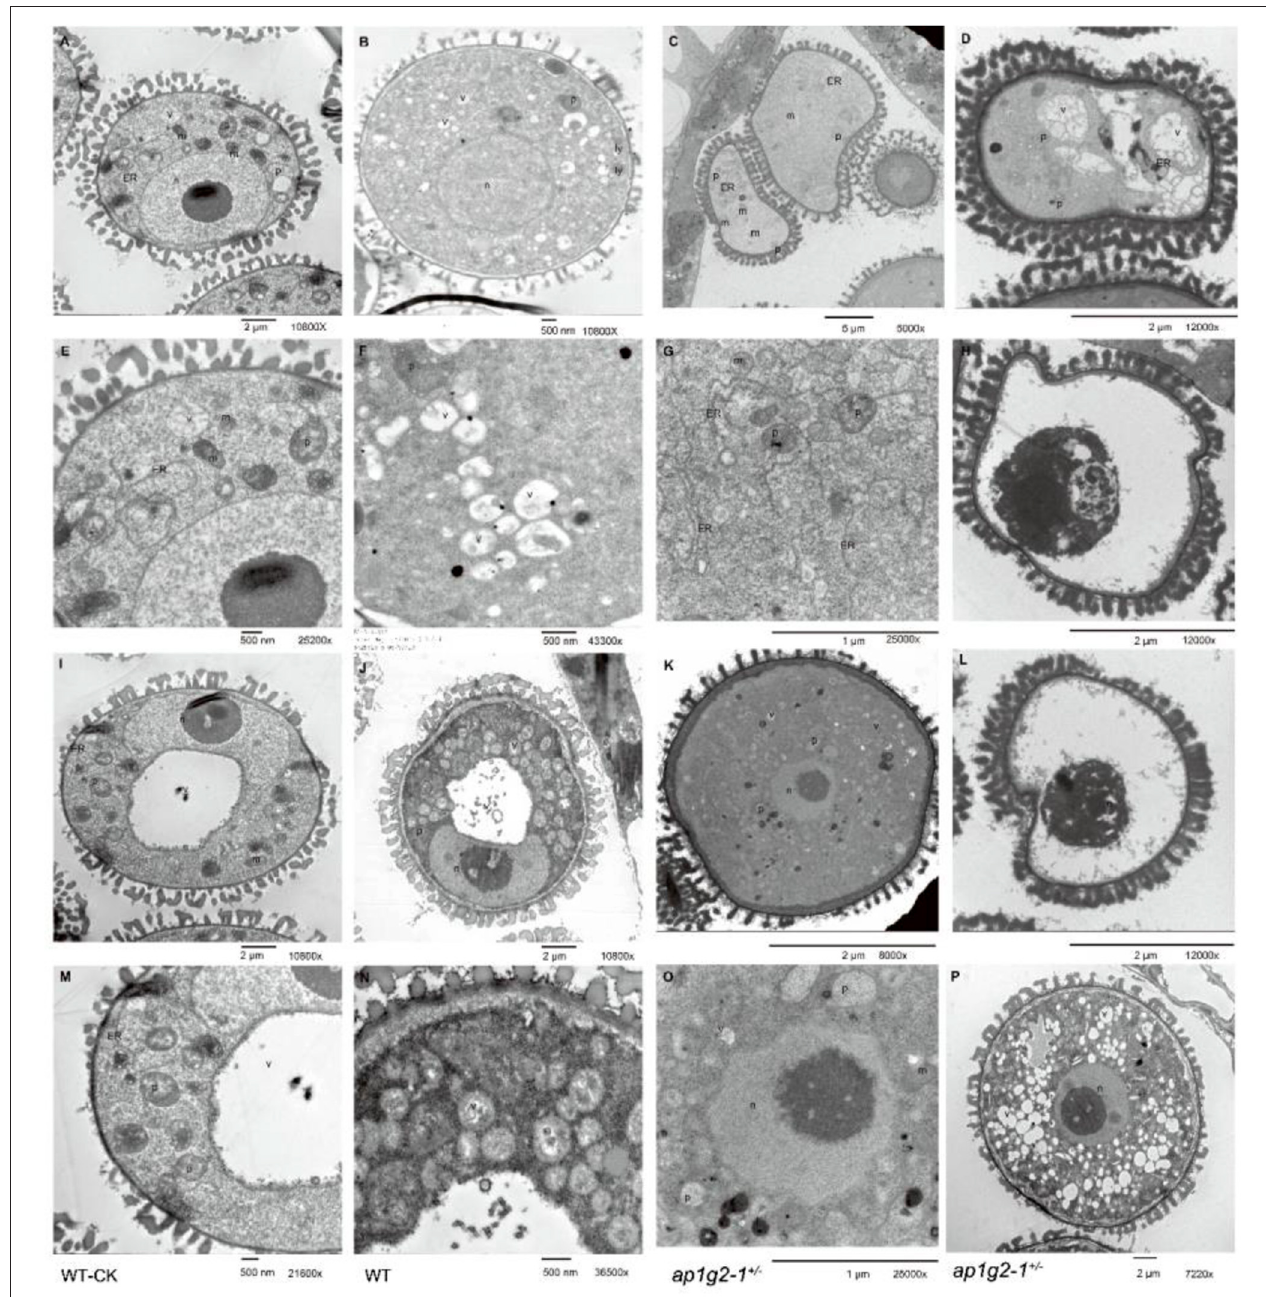
FIGURE 11 | TEM of pyroantimonate-labeled microspores from the wild type and ap1g2-1 + / − . (A,I) The microspores before pollen mitosis I from the wild type without potassium pyroantimonate treatment. (E,M) The magnifications of (A,I) . (B,F,J) The microspores before PMI from the wild type with potassium pyroantimonate treatment. (N) The magnifications of (J) . (C,D,G,H,L) Abnormal microspores failed to undergo pollen mitosis I from ap1g2-1 + / − . (K,O,P) were normal biocellular pollens from ap1g2-1 + / − . (G,O) were the magnifications of (C,K) . n, nucleus; ER, endoplasmic reticulum; p, proplastids; v, vacuoles; m, mitochondria; ap, autophagosomes; a, amyloplasts; ly, lysosome.